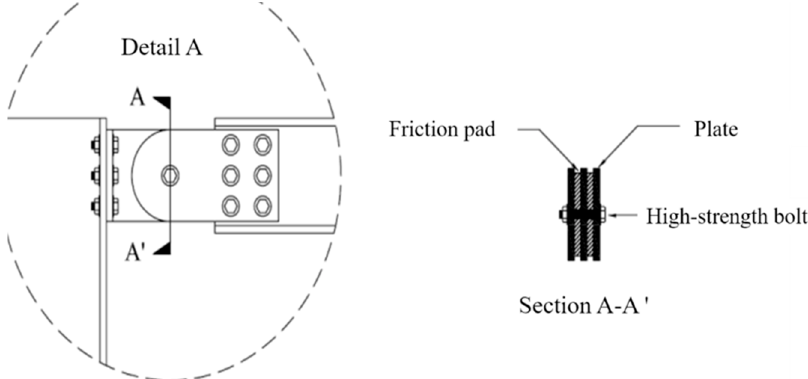
Figure 4. Beam-end rotational damper.